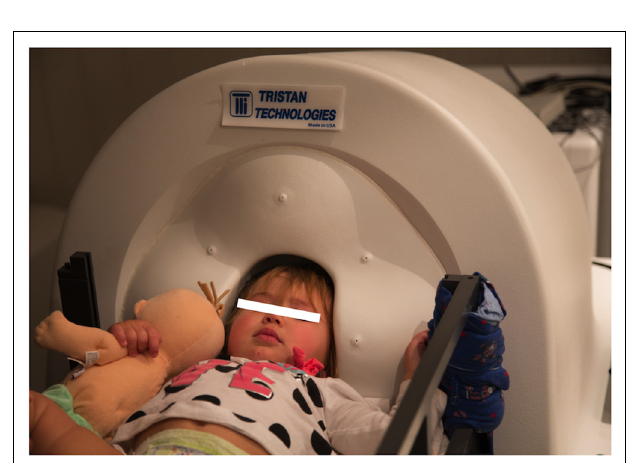
FIGURE 5 |A 14-month-old participant undergoing MEG recording.